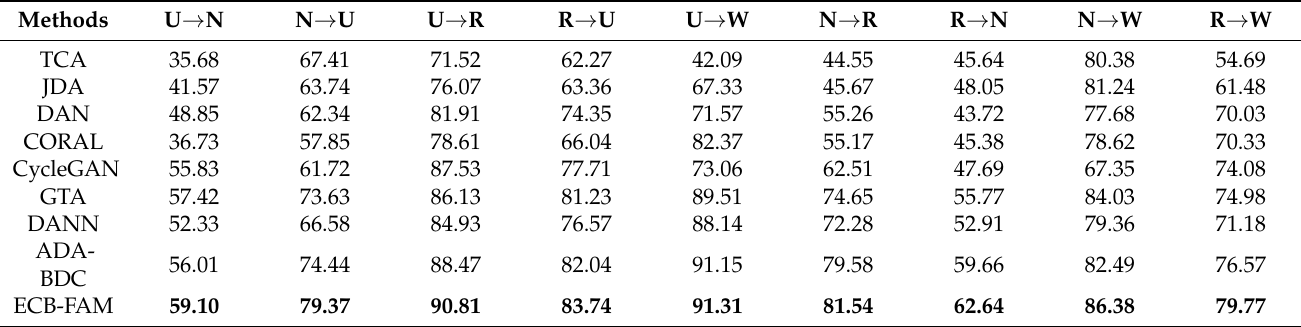
Table 4. Detailed results of the proposed framework comparing with the baseline methods. Accuracy (% as the unit) is used as the